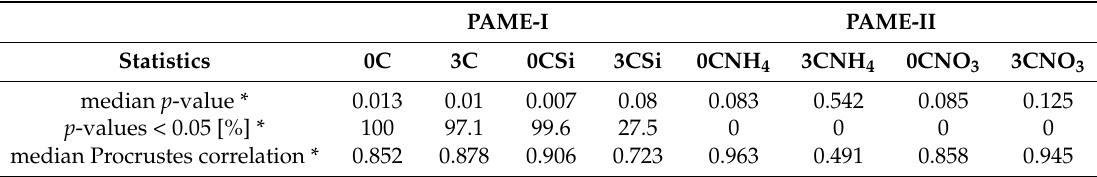
Table 4. Median p -values, the percentage of significant p -values (<0.05) and median correlation values issued from 1000 non-metric multidimensional scaling (NMDS) permutations of denaturing gradient gel electrophoresis (DGGE) and pulsed field gel electrophoresis (PFGE) band patterns are presented for the two different enrichment experiments (PAME-I and -II) and the different tanks. 0 × C: no addition of carbon, 3 × C: three Redfield additions of carbon in form of glucose. Si = Silicate. PAME-I PAME-II Statistics 0C 3C 0CSi 3CSi 0CNH 4 3CNH 4 0CNO 3 3CNO 3 median p -value * 0.013 0.01 0.007 0.08 0.083 0.542 0.085 0.125 p -values < 0.05 [%] * 100 97.1 99.6 27.5 0 0 0 0 median Procrustes correlation * 0.852 0.878 0.906 0.723 0.963 0.491 0.858 0.945 * Issued from 1000 non-metric multidimensional scaling NMDS